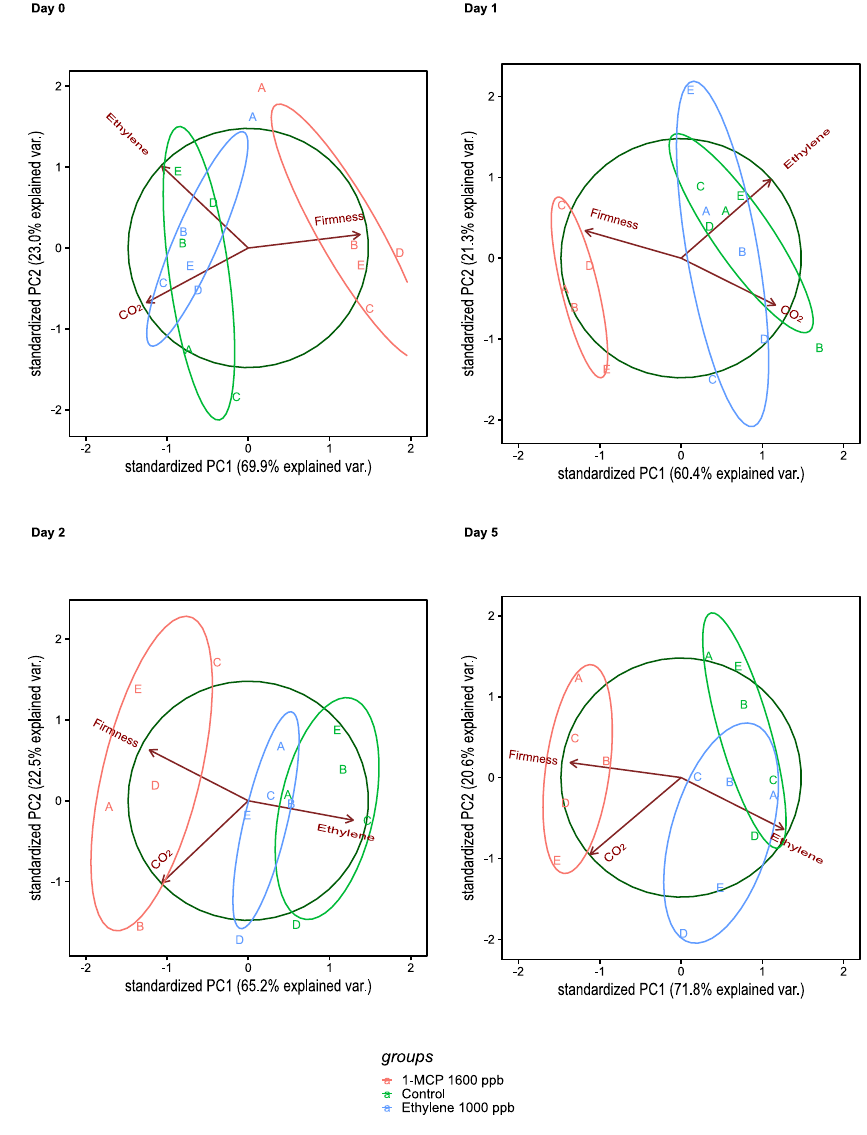
Figure 9. PCA biplot for ethylene, CO 2 and firmness indices of raspberry ( Rubus idaeus ‘Heritage’) fruit during treatment with ethylene and 1-methyl cyclopropane (1-MCP) at 10 °C. The storage assay was performed at the W stage of the raspberries and stored for 5 days and at 10 °C. The PCA analysis was conducted on each sampling day.